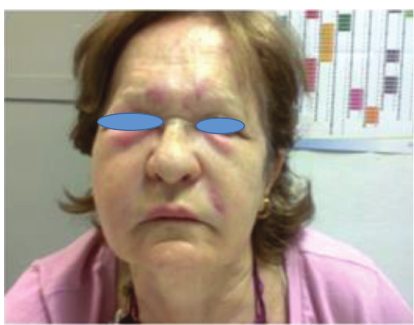
Figure 1: First visit to the Emergency Room. Erythematous plaques in supraciliary and malar areas.